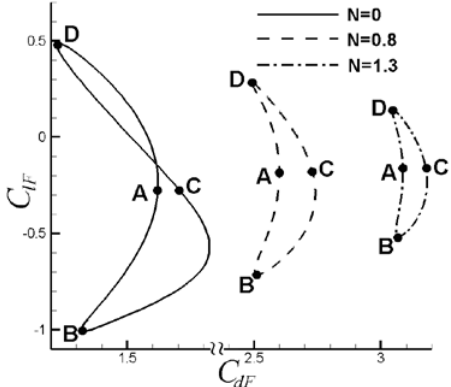
Figure 11. Lift–drag phase diagrams with different values of interaction parameter N for shear rate K = 0.2